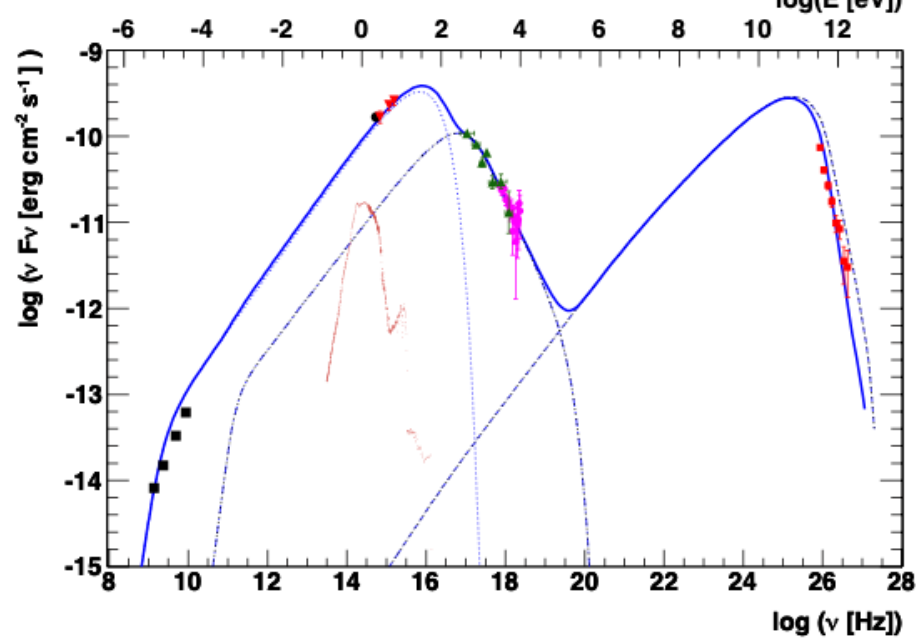
Figure 1. A typical stationary SSC model for the high-frequency peaked BL Lac object PKS 2155 − 304. See text for details. Credit: [15], A&A, reproduced with permission